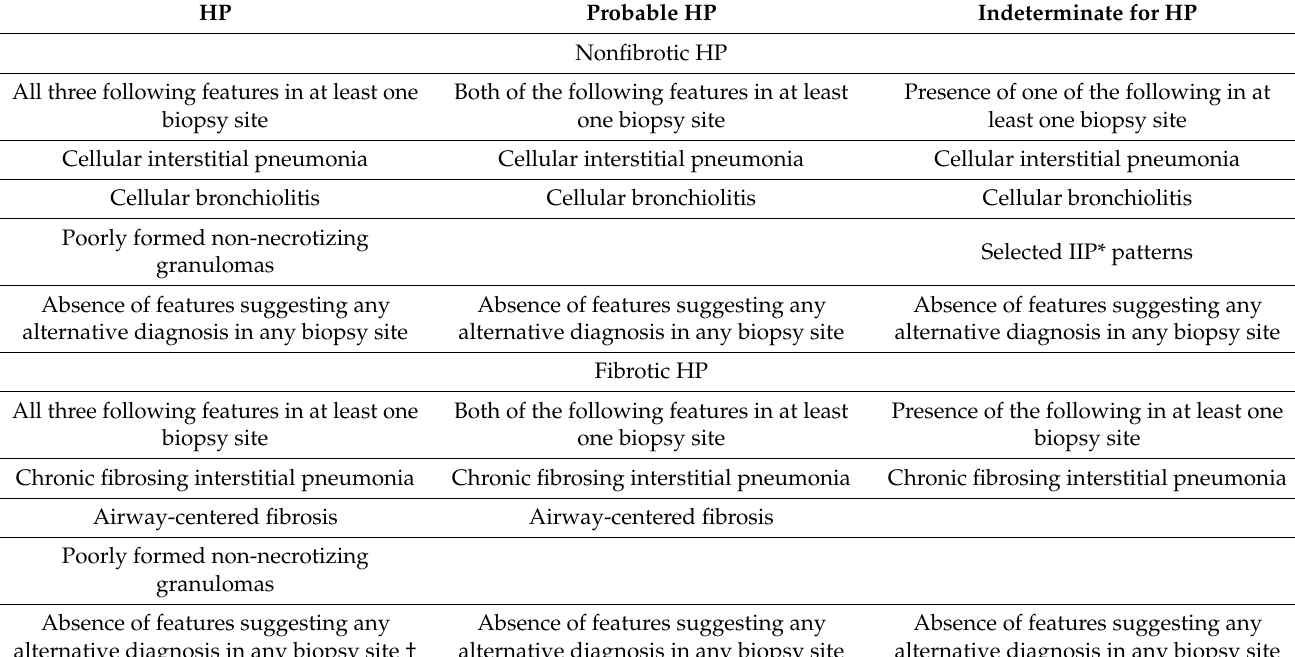
Table 5. Histopathological features of